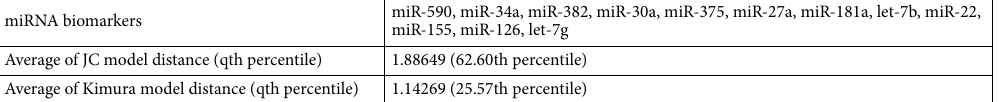
Table 7. The pairwise distance of 12 miRNA biomarkers of major depression and migraine.